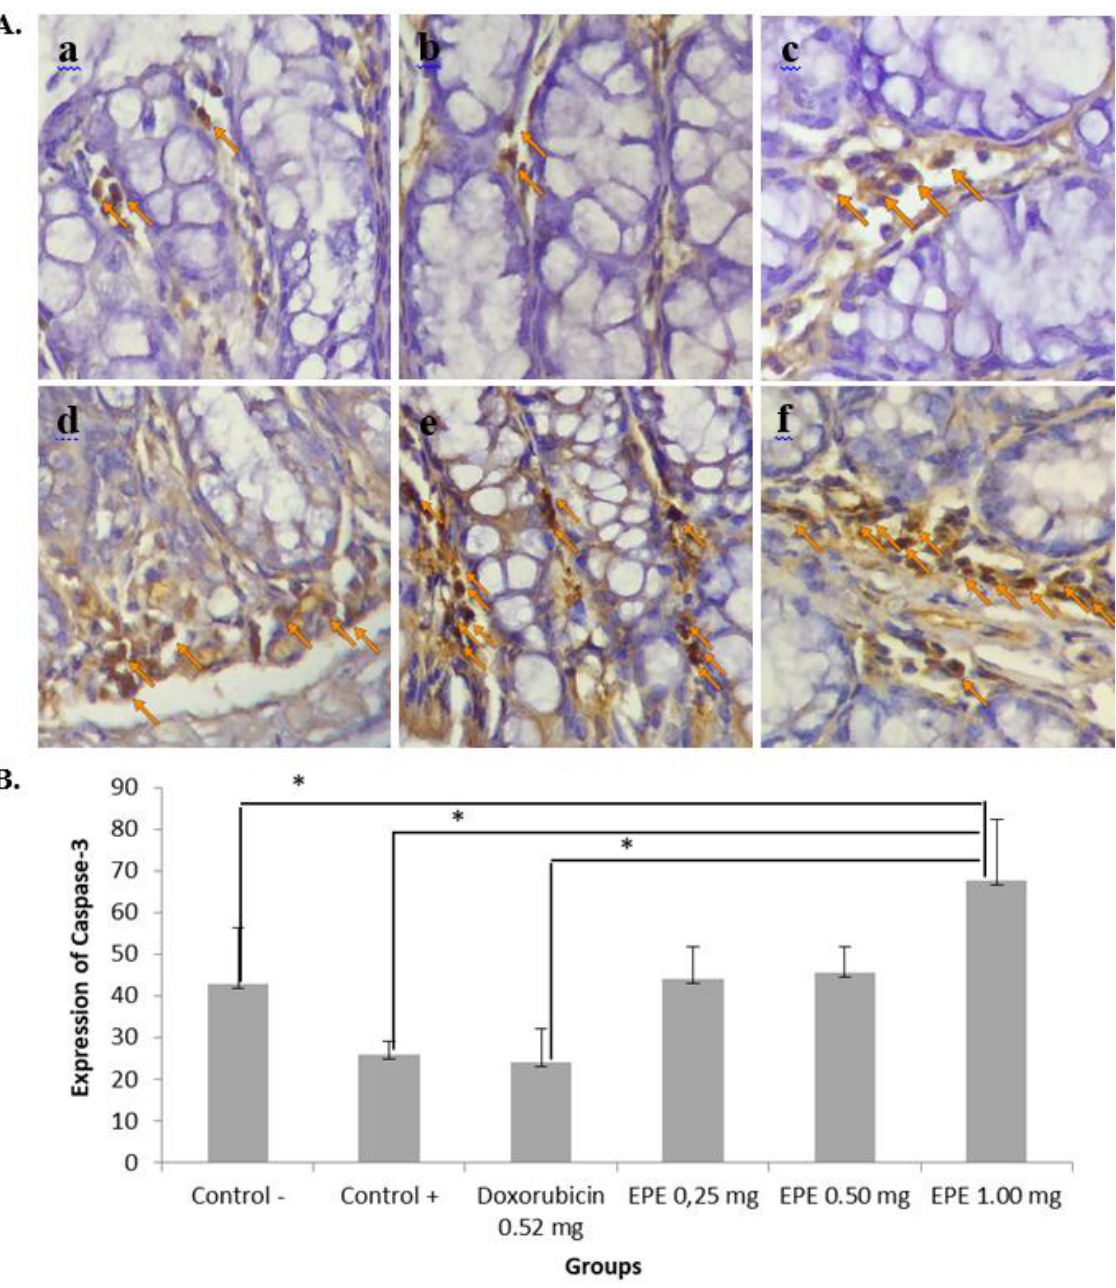
Figure 4. A. Immunohistochemical staining of caspase-3 expression of murine models of the colon tissue of colitis-associated colon cancer model mice after EPE treatment. 400x magnification. (a) Negative control, (b) Positive control (c) Doxorubicin 0.052 mg/20gBW, (d) EPE 0.25 mg/20gBW, (e) EPE 0.50 mg/20gBW, (f) EPE 1.00 mg/20gBW. The arrow indicates the expression of Caspase-3 (apoptosis). B. Graph of caspase- 3 expression mean data in animal models colon induced with AOM-DSS after EPE therapy. * p